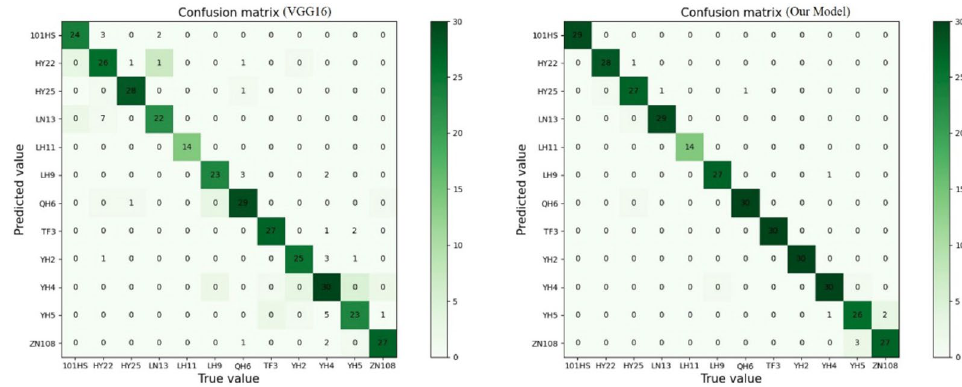
Figure 7. Model confusion matrix comparison.